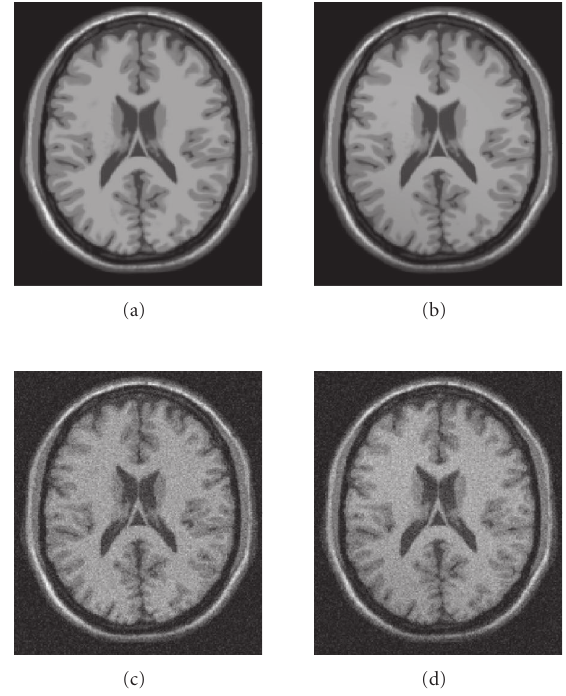
Figure 2: BrainWeb simulated images: original image (a), image with 40% inhomogeneity (b), image with 9% noise (c), and image with both artifacts